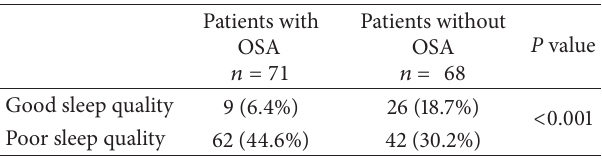
Table 3: Relationship between quality of sleep and obstructive sleep apnea (OSA) in studied